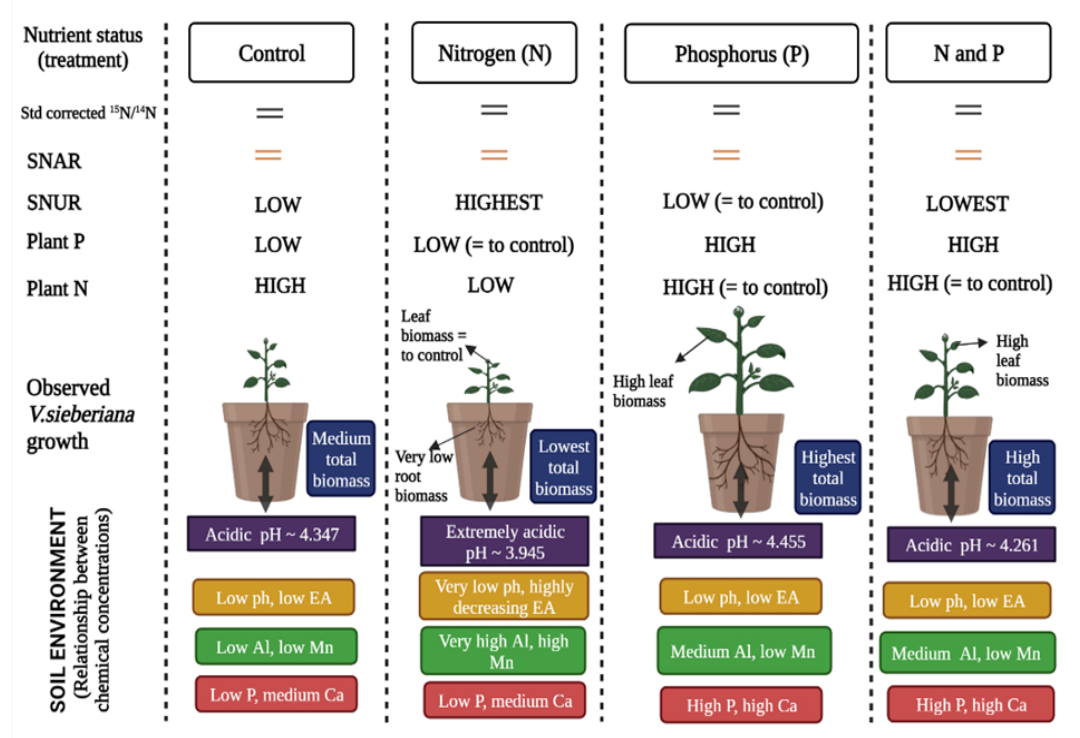
Figure 7. A visual representation of the effects of nitrogen and phosphorus enrichment on soil chem- ical properties and growth dynamics of Vachellia sieberiana . “=” means that the effect of the treatment was non-significant.